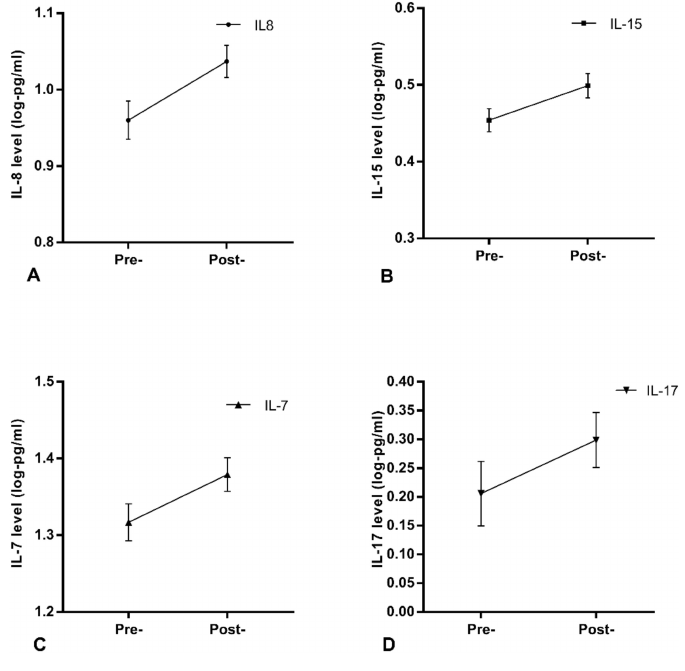
Figure 1. Protein increases with psychological